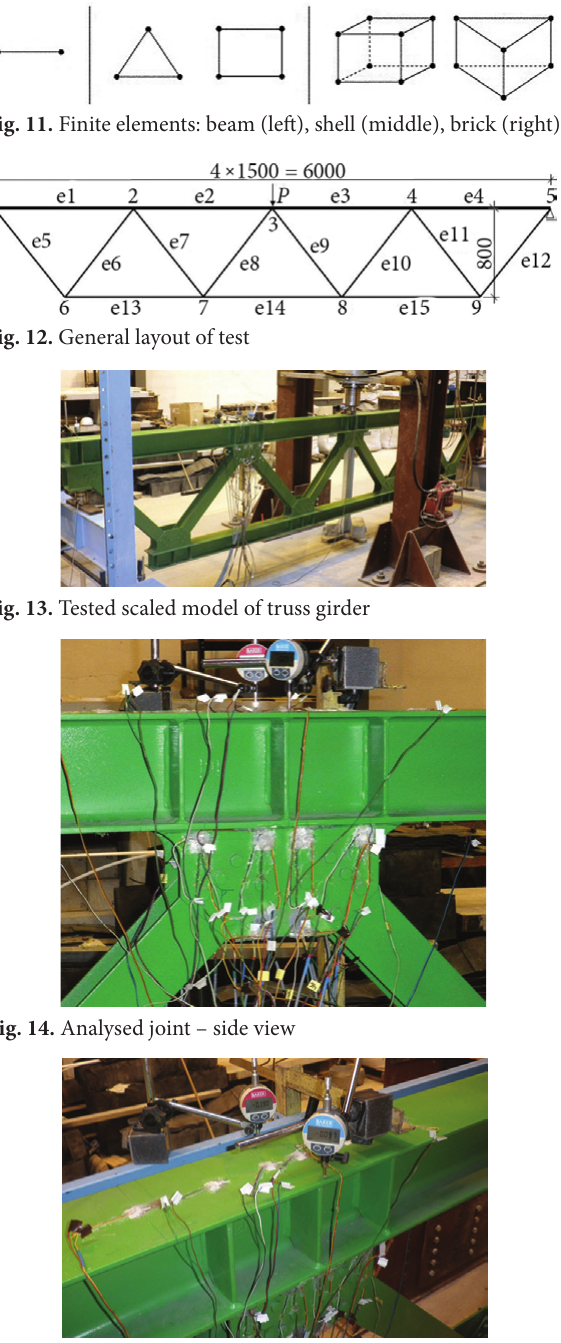
Fig. 15. Analysed joint – top